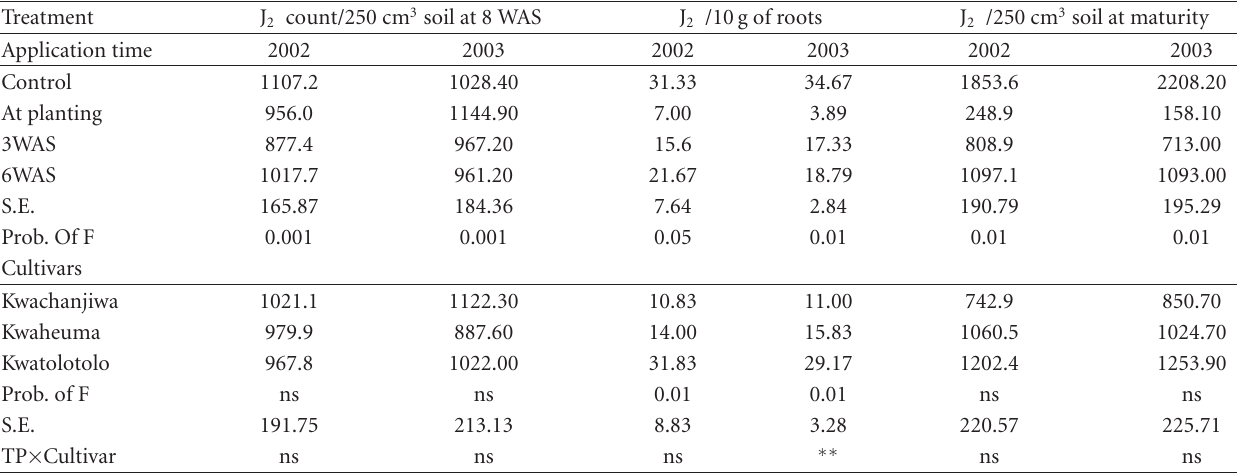
Table 1: E ff ects of carbofuran on the characteristics of M. javanica on bambara groundnut taken in 2002 and 2003 cropping seasons.